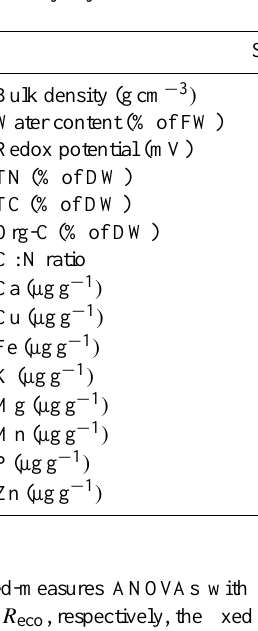
Table 1. Physical/chemical topsoil characteristics (0–5cm depth for bulk density, water content and redox potential; else 0–4cm depth) at the five wetland sites (two Suaeda salsa wetlands, two Phragmites australis wetlands and one rice paddy) in the Liaohe Delta, Northeast China. Data were collected in 2013 by Siyuan Ye.